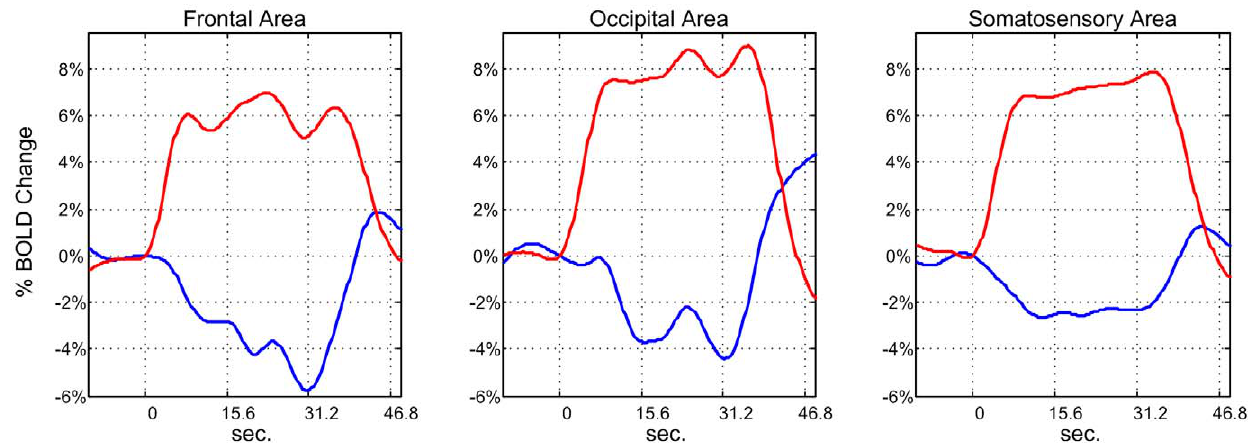
Figure 2. The spline-fitted mean sNBR and PBR. The spline-fitted mean sNBR and PBR values for frontal, occipital and somatosensory groups taken from left hand data.